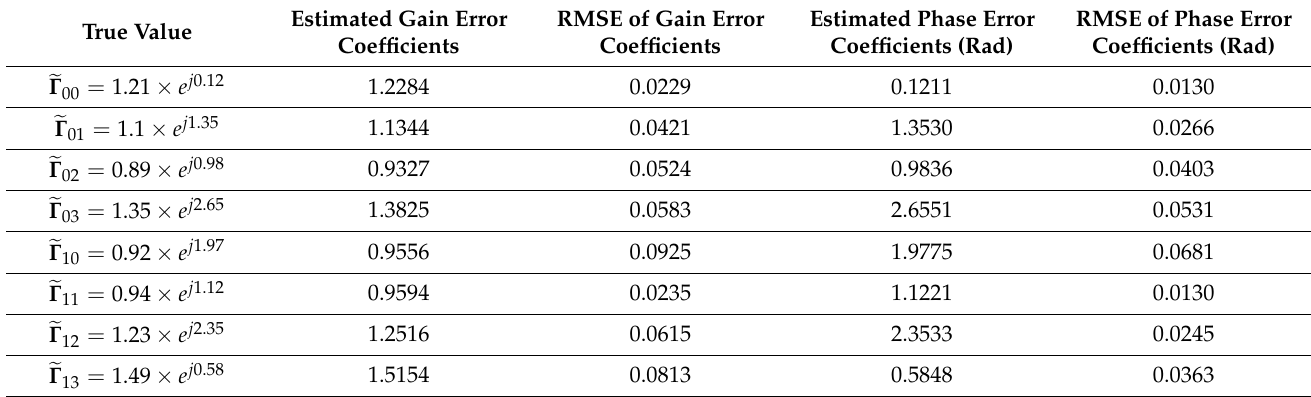
Table 1. Mean and RMSE of the gain-phase error coefficients.